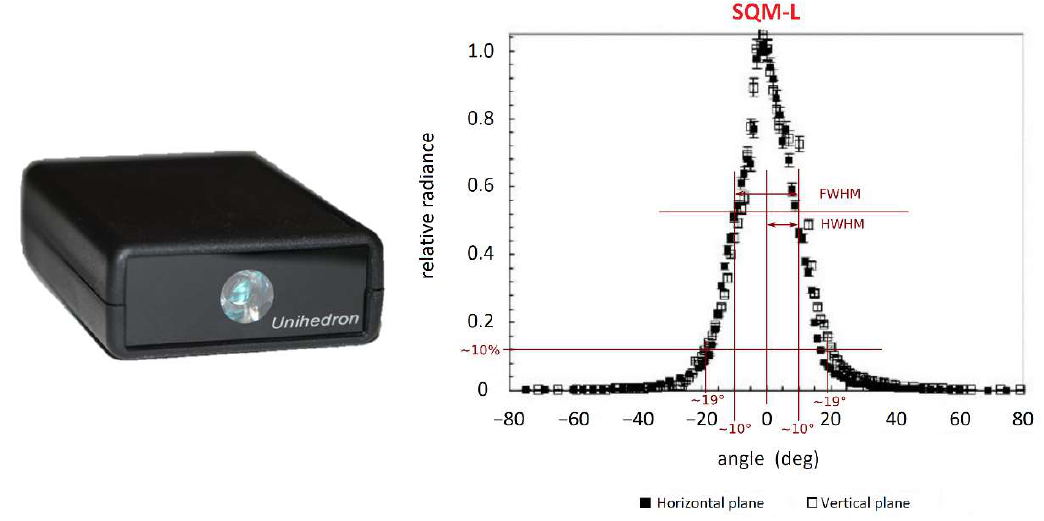
Figure 1. Image of SQM-LE unit ( left ) and manufacturer’s declared calibration curve ( right ) [11,12].